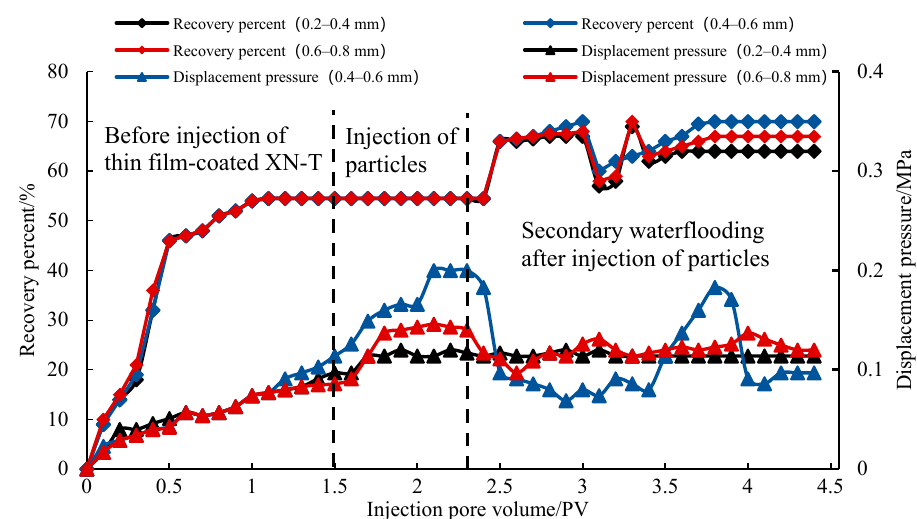
Figure 8. Displacement pressure curves and recovery percent curves for variable particle sizes.